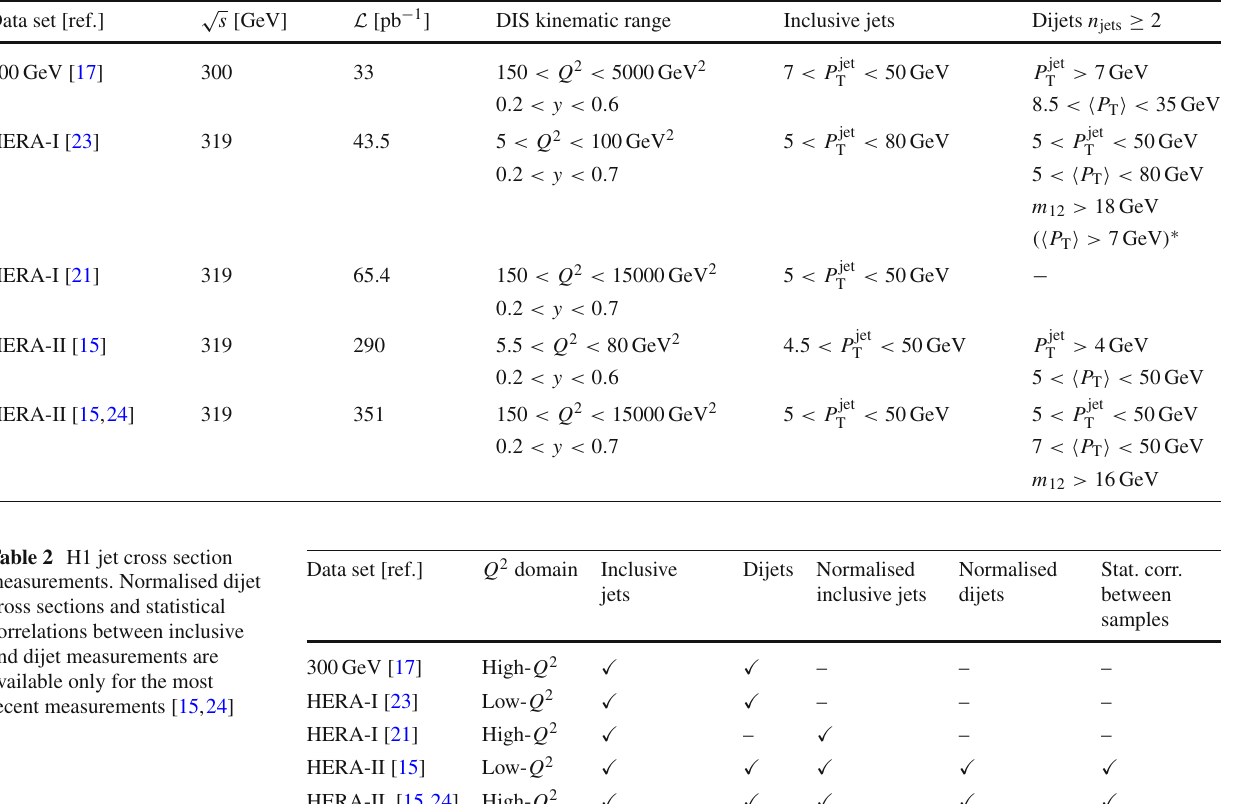
Table 1 Summary of the kinematic ranges of the studied inclusive jet a requirement on the pseudorapidity of the jets, − 1 < η jet √ s and the integrated not shown in the table. Dijet events are defined by extra cuts or on the and dijet data sets. The ep centre-of-mass energy average jet transverse momentum (cid:3) P T (cid:4) or the invariant mass of the two luminosity L are shown. Kinematic restrictions are made on the neg- ative four-momentum transfer squared Q 2 , the inelasticity y and the leading jets m 12 . The asterisk denotes a cut not present in the original work [23] but imposed for the present analysis jet transverse momenta P jet as indicated. Common to all data sets is T Data set [ref.]